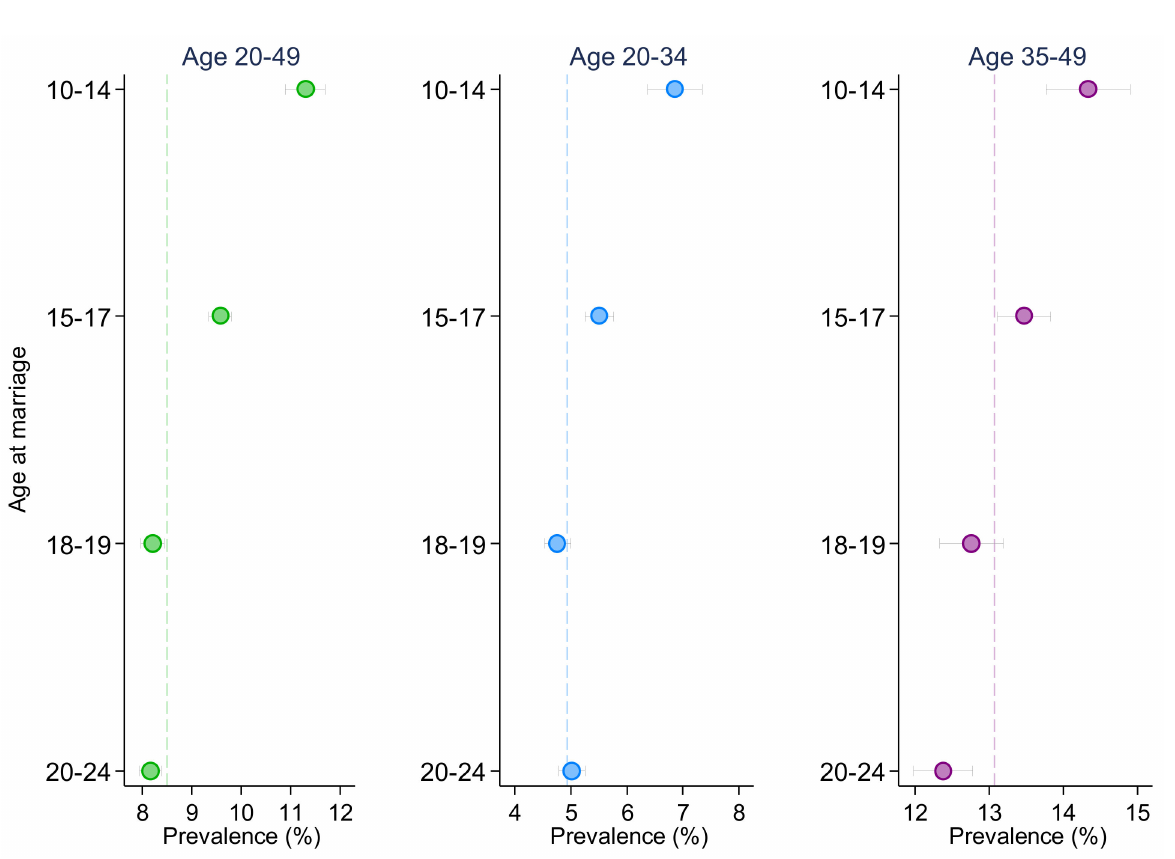
Figure 2. High blood glucose prevalence by age at marriage. Estimates were obtained using com- plex survey weights. The horizontal lines across the markers represent 95% confidence intervals. The vertical dashed lines represent the average high blood glucose prevalence rates in respective age